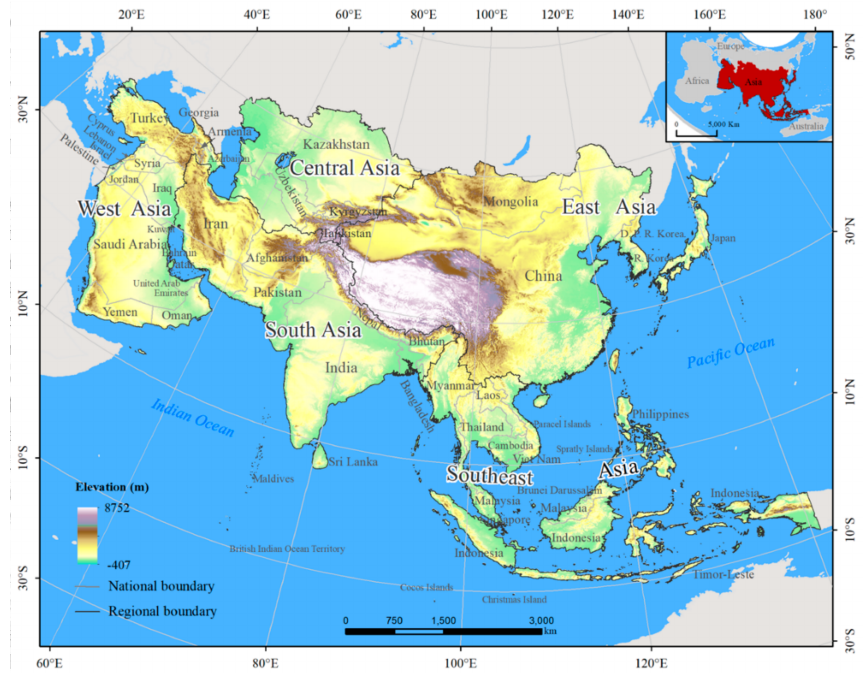
Figure 1. The study